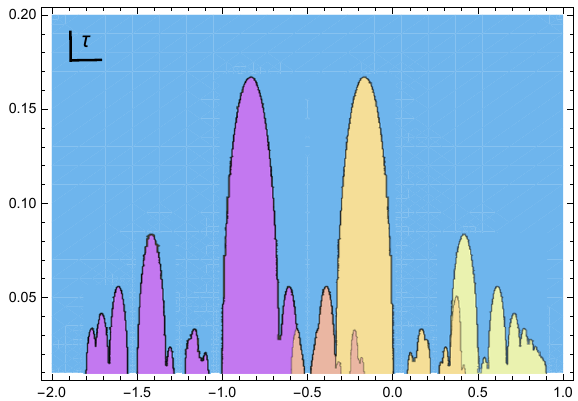
Figure 7 . The phase structure for (cid:28) 2 (cid:21) 0 : 1. Apart from the phases (cid:28) 2 ! 1 , there are two dominant phases (1 ; 0) and (1 ; 1) in the semi-circular regions. Here we have scanned f ( m; n ) j m = 0 ; : : : 30 ; n = (cid:0) 30 ; : : : ; 30 g with gcd( m; n ) = 1.